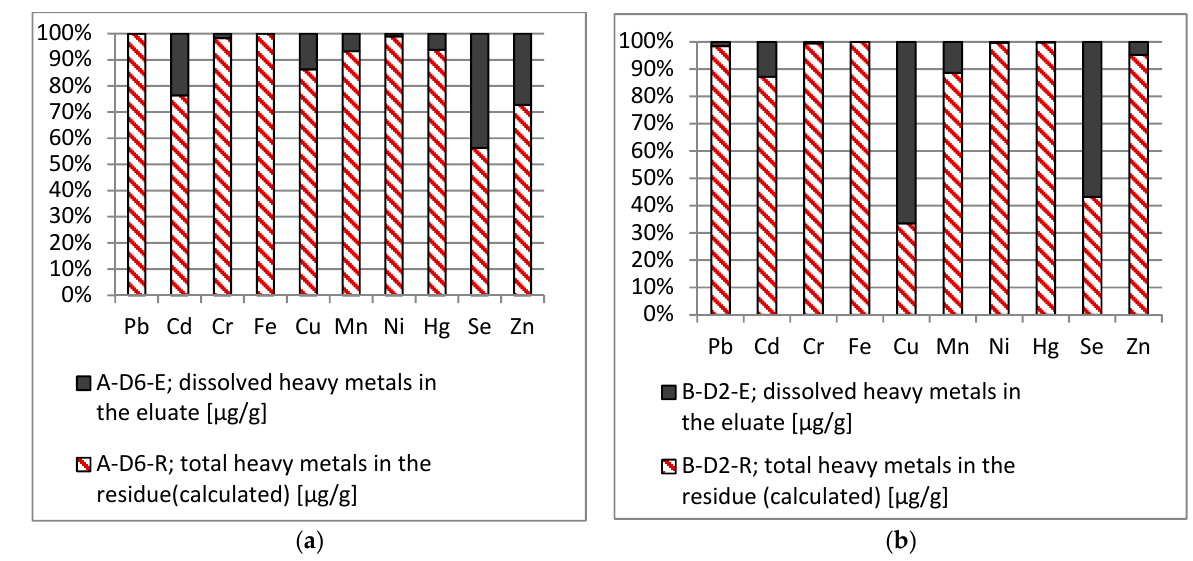
Figure 4. Comparison of total and dissolved heavy metals of ( a ) dust A-D6 (%) and ( b ) dust B-D2 (%.) Table 8. Comparison of the emission standards and threshold values with the dust samples. Parameter Korea